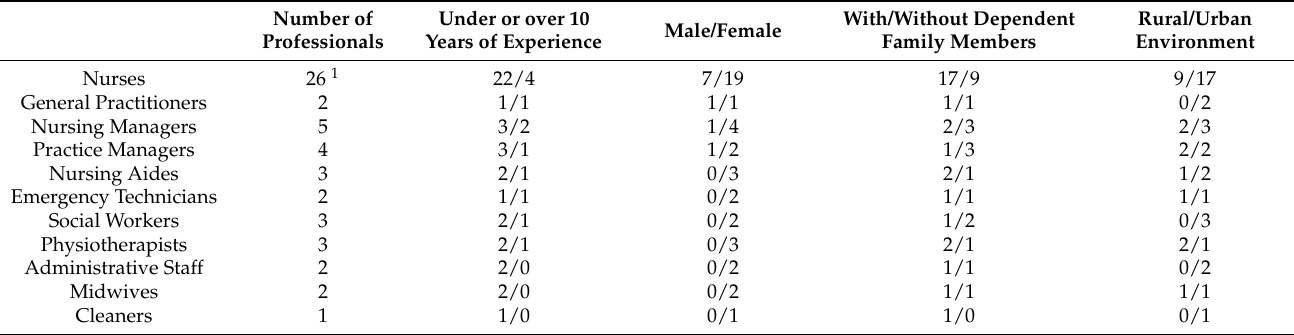
Table 1. Profiles and characteristics of the participants in the